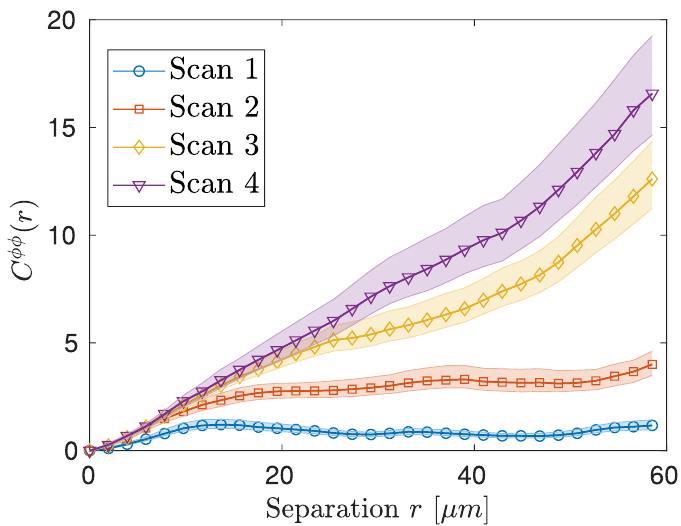
Figure 5: Scaling of phase auto-correlations C φφ ( r ) as a function of the distance r from the reference point (middle) in the initial state. Scan 1 corresponds to a massive Gaussian state, scans 2, 3 and 4 correspond to non-Gaussian states at different interaction strength. The bands indicate the size of the estimated errors